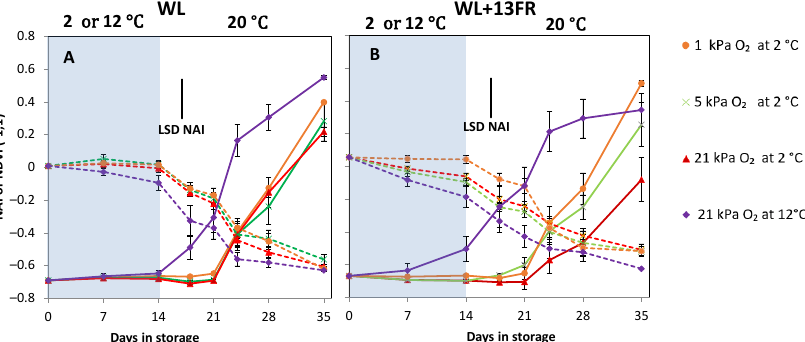
Figure 7. Colour indicated by NDVI (dotted lines) or NAI (full lines) values of MG tomatoes cultivated under white LED light (WL) without far red lighting ( A ) or with far red lighting during cultivation ( B ) during cold storage (blue area) at 2 or 12 °C and subsequent shelf-life at 20 °C (white area). Orange, green, red and purple lines and symbols indicate 1, 5 and 21 kPa O 2 (low oxygen control) applied during storage at 2 °C, and 21 kPa O 2 at 12 °C (temperature control), respectively. The average NDVI and NAI values with indicated standard error are shown for two replicates of four tomatoes ( n = 2). LSD values ( p < 0.05) are indicated per panel.